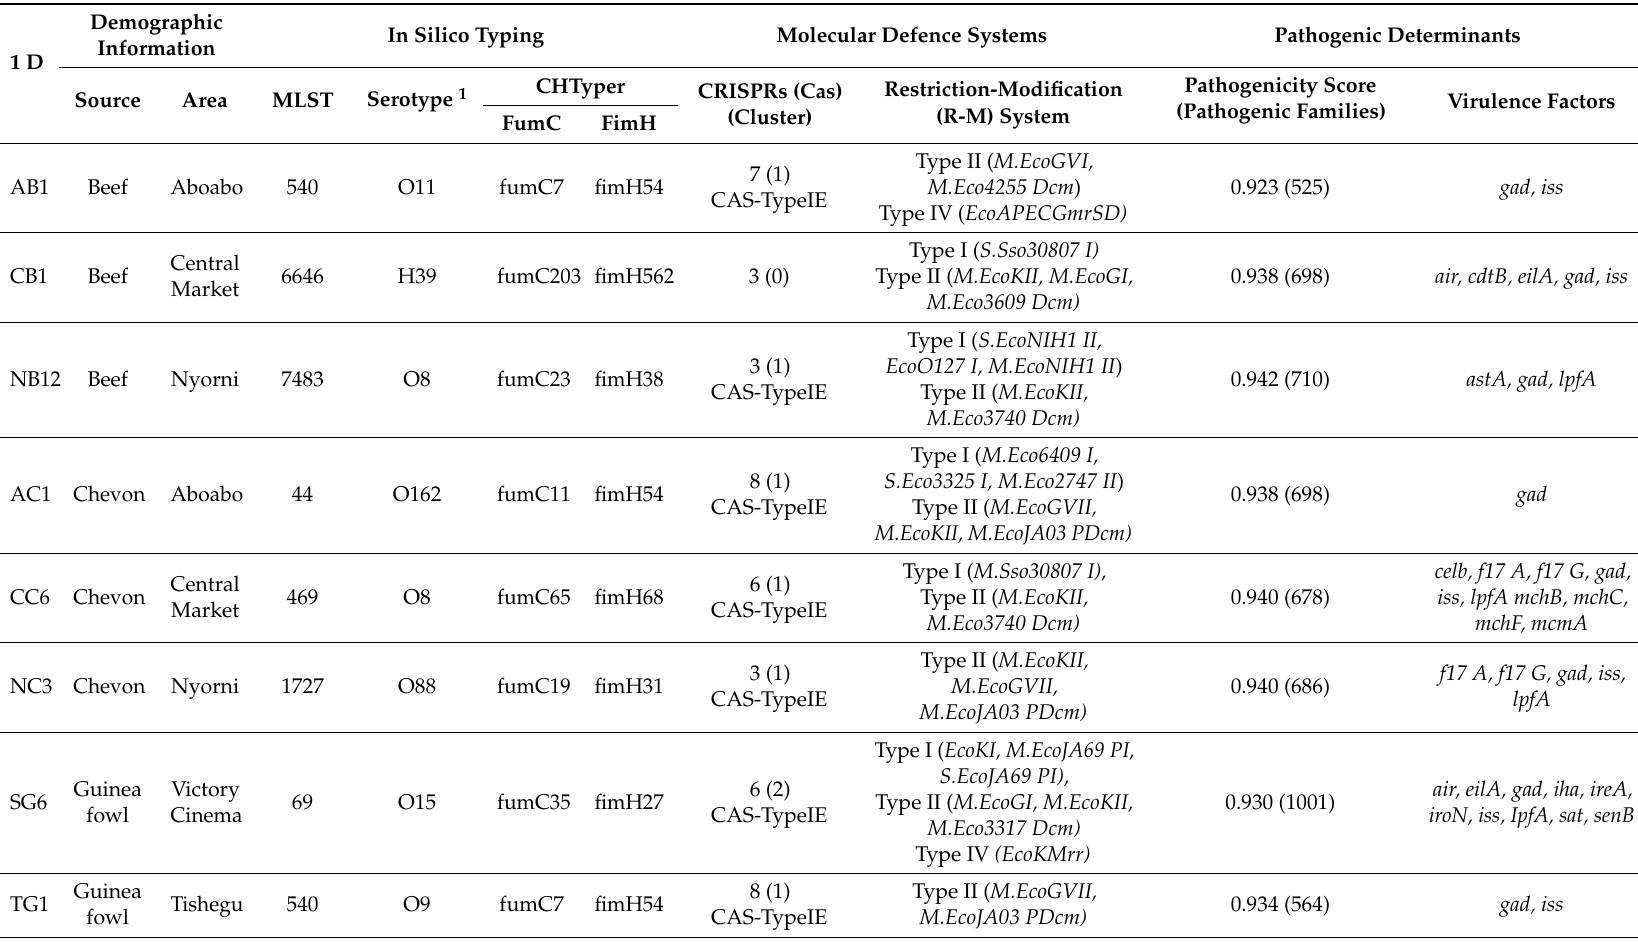
Table 1. Summary of the population, the source of specimens, sample type, and genotypic characteristics of the